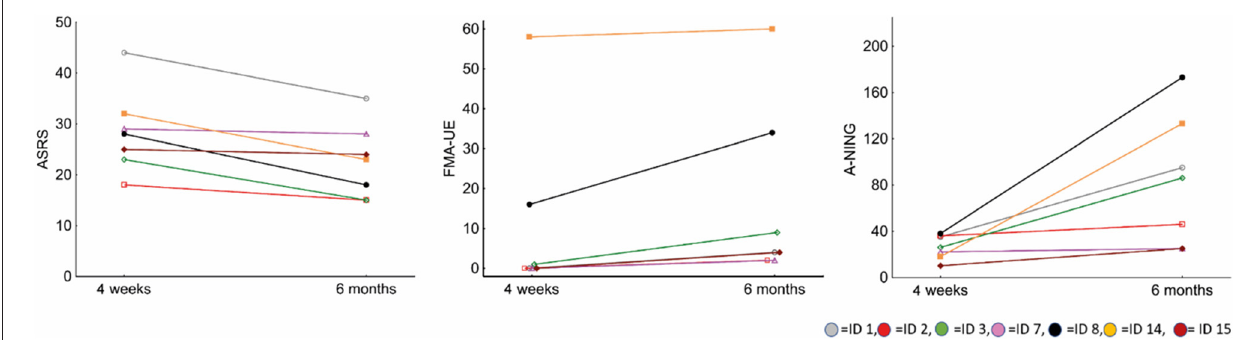
FIGURE 3 | Total score changes between A1 and A2 in ASRS, FM-UE, and A-NING. In ASRS, higher scores reflect greater severity.